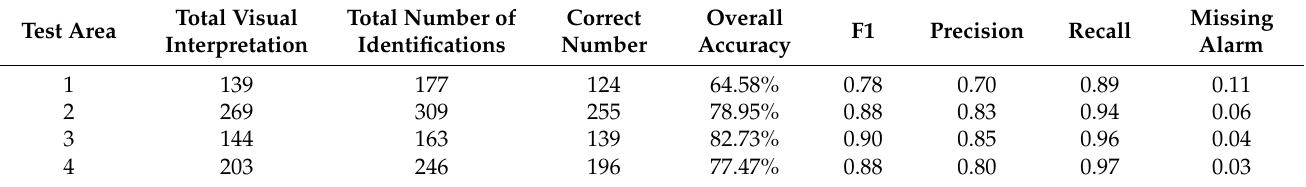
Table 3. The accuracy identification using D-SCNet.